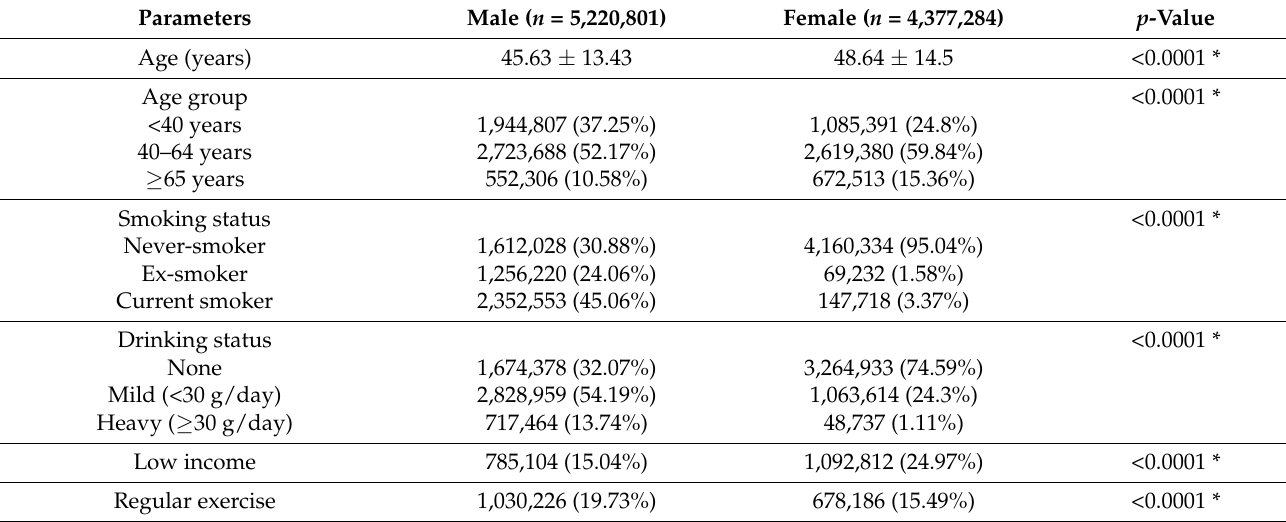
Table 1. Baseline characteristics of the original cohort of